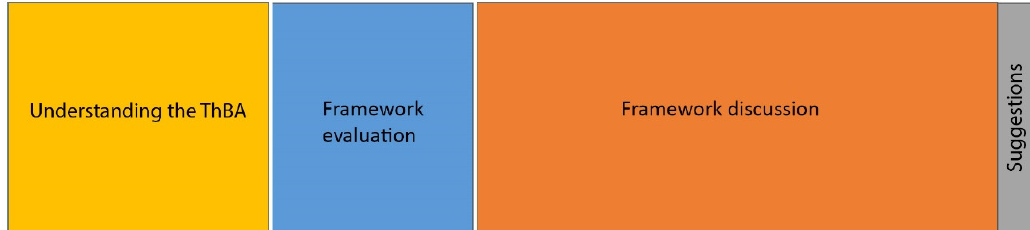
Figure 4. Proportional representation of all references coded for the main themes.